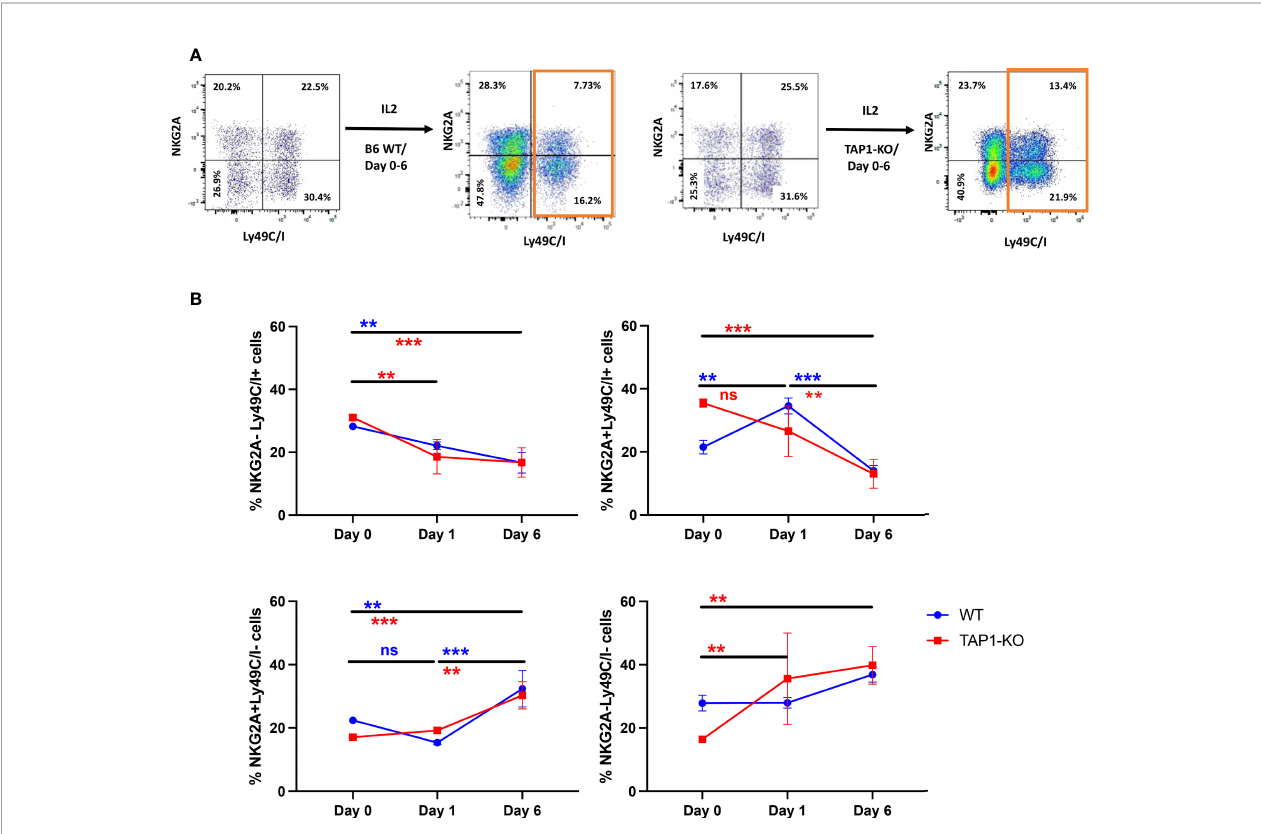
FIGURE 9 | (A) Representative fl ow cytometric dot plots of splenic NK cells distinguished according to NKG2A and Ly49C/I expression. The NK cells were expanded in the presence of IL-2 for 6 days and the expression levels of NKG2A and Ly49C/I were compared with that of day 0. (B) Analyses of the frequency of NK cell subsets based on NKG2A and Ly49C/I expression levels. The frequency between day 0, day 1 and day 6 for IL-2 expanded NK cells was compared. Statistical analysis was performed using GraphPad Prism 9.0.0 with an ordinary two-way ANOVA with Sidak multiple comparisons tests (n=3). **, p<0.01, ***, p<0.001 and ns, not signi fi cant. The colors of the * correspond to the strains of mice